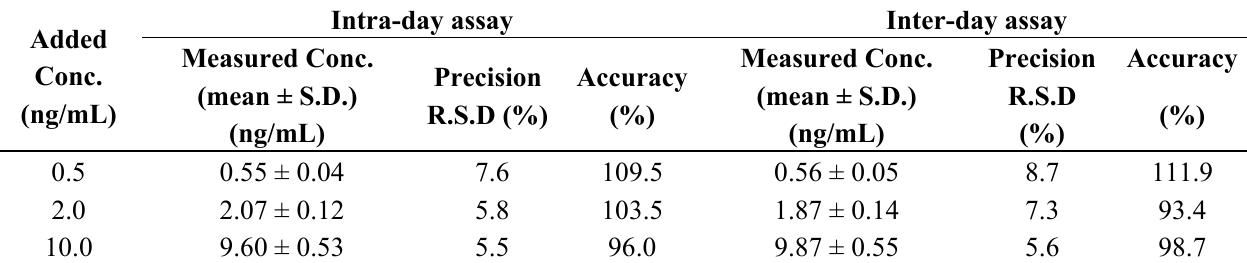
Table 2. Acurracy and precision of clenbuterol by